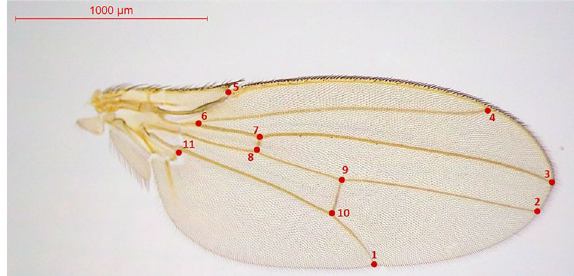
Figure 1. The positions of 11 landmarks (red points) used in shape